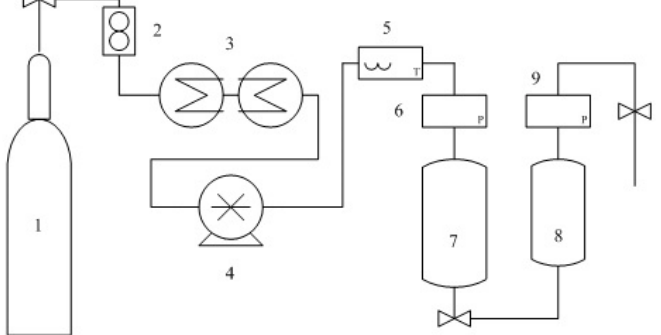
Figure 3. Scheme of the experimental set-up for supercritical CO 2 fluid extraction. 1: CO 2 feed tank; 2: flow meter; 3: cryostat; 4: pump; 5: heater; 6: manometer; 7: extraction tank; 8. Separation tank; 9. manometer.